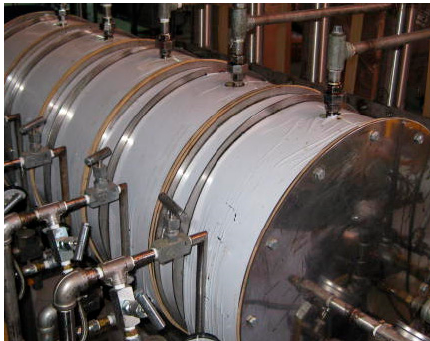
Figure 1. Equipment prototype of continuous distillation.